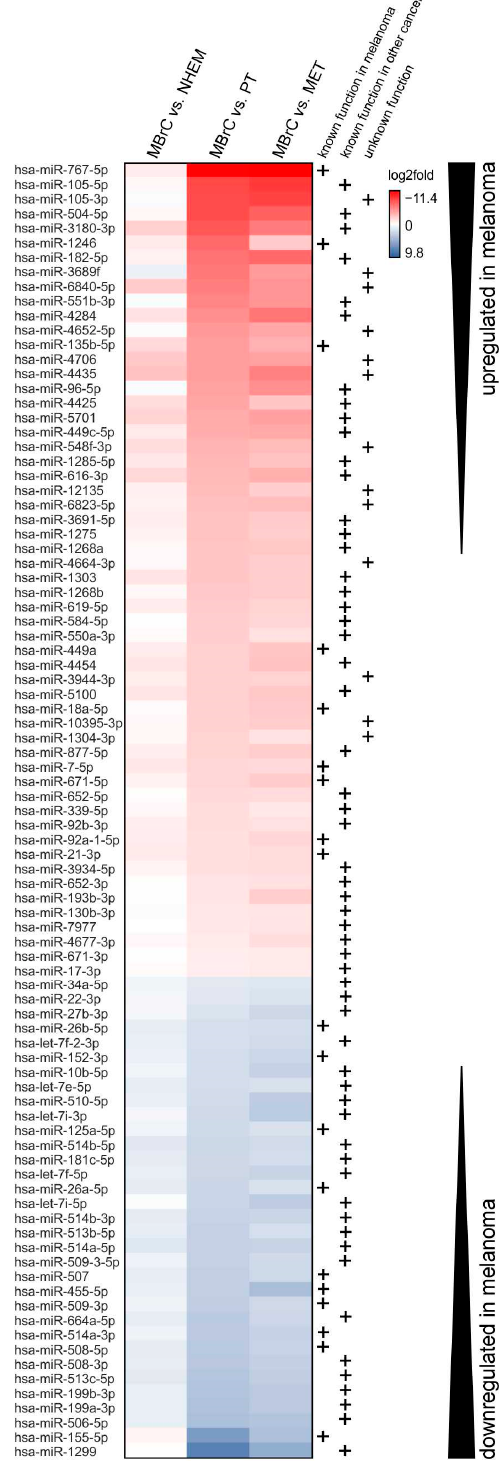
Figure 2. Significantly differentially expressed miRNAs in melanoma cells. Heatmap of log2fold values of all miRNAs that were not regulated in MBrCs vs. NHEMs ( p > 0.05), but differentially expressed ( p < 0.05) in MBrCs vs. melanoma primary tumor (PT), and MBrCs vs. melanoma metastasis-derived (MET) cell lines. miRNAs, which were upregulated in melanoma compared to MBrCs are shown in red, and miRNAs downregulated in melanoma are shown in blue. Both are indicated by black arrows. Mentions in the literature of functional relevance of the respective miRNA in melanoma or other cancers are depicted by +.